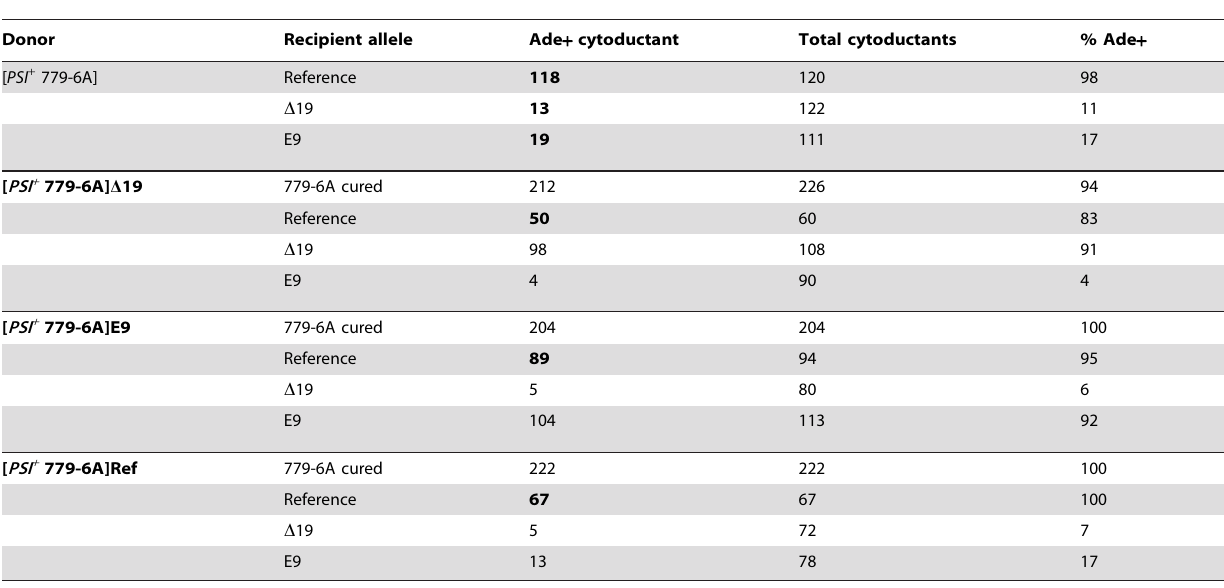
Table 3. Transmission of 779-6A’s [ PSI + ref] carried by other Sup35